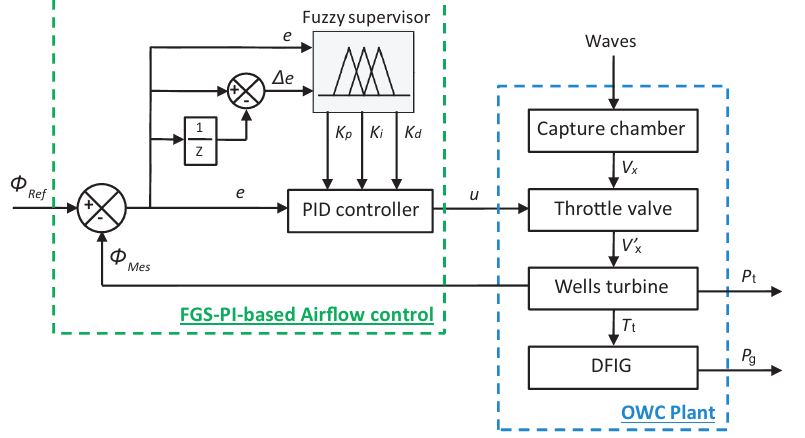
Figure 12. FGS-PID-based airflow control scheme for